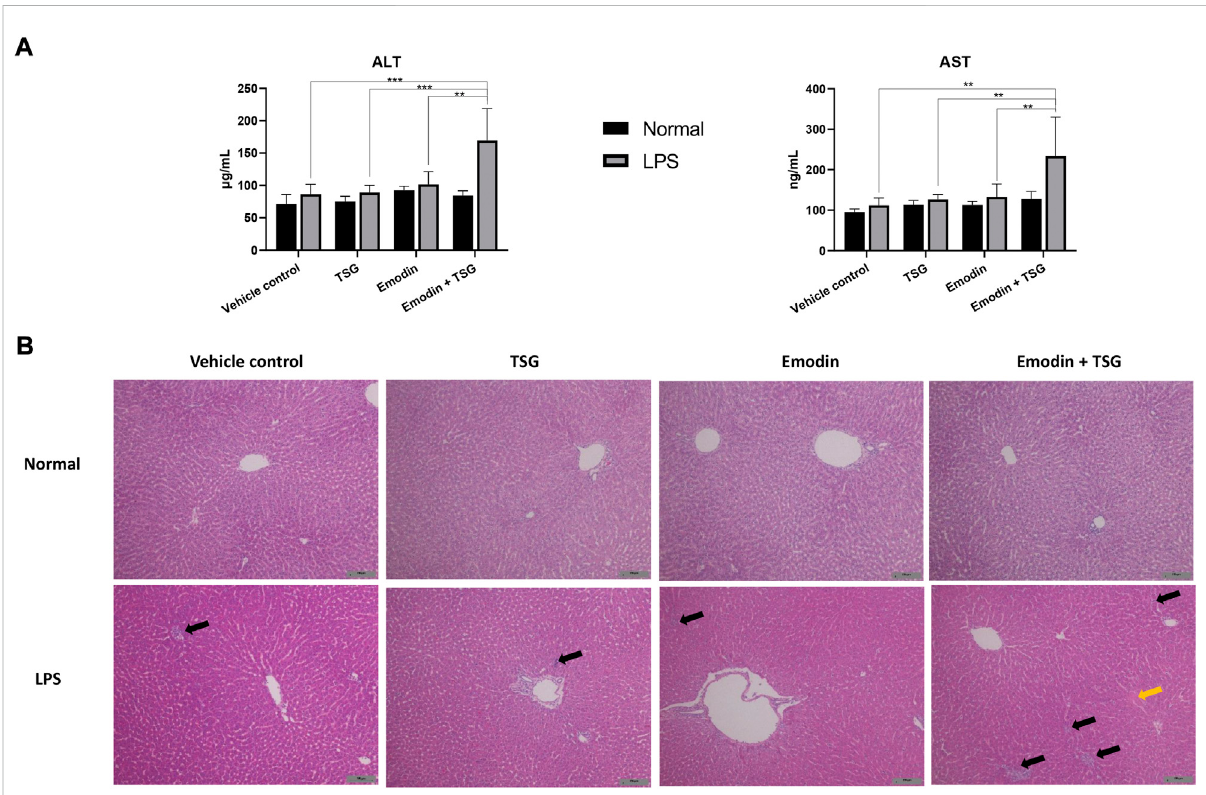
FIGURE 3 Plasma levels of ALT and AST (A) and histology changes in the liver (B) , H&E staining, ×100 magni fi cation) after treatment with emodin, TSG, or their combination in normal and LPS-mediated in fl ammatory stress model rats. The data are expressed as mean ± SD ( n = 6). ** p < 0.01, *** p < 0.001 by two-way ANOVA followed by the Tukey post hoc test. The solid black arrows indicated in fl ammatory cell in fi ltration, and the solid yellow arrow pointed to cell swelling. The scale bar represents 100 μ